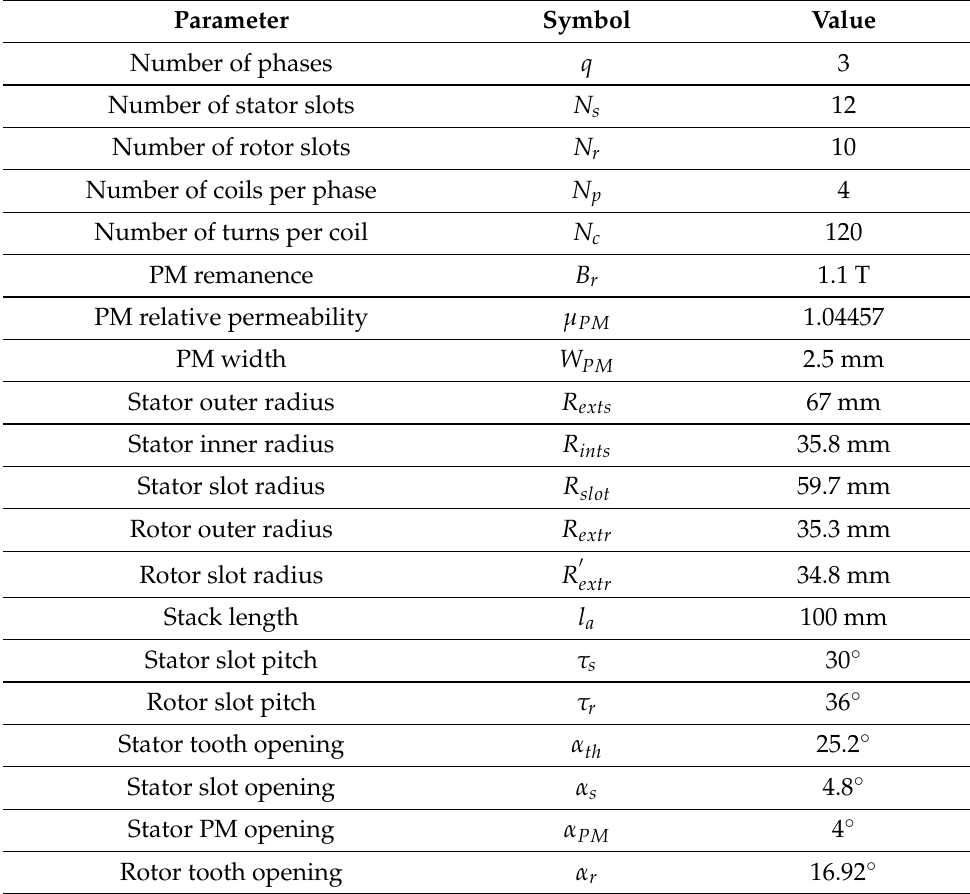
Table 1. Design and geometrical parameters of the FSPMM under